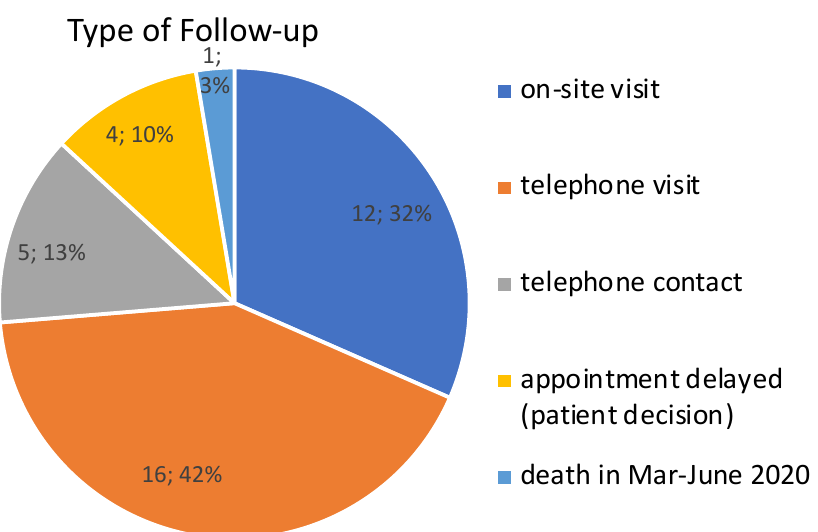
Figure 3. Type of follow-up in the period between 1 st March and 31 st May 2020 for the 38 patients with highly aggressive ALS.